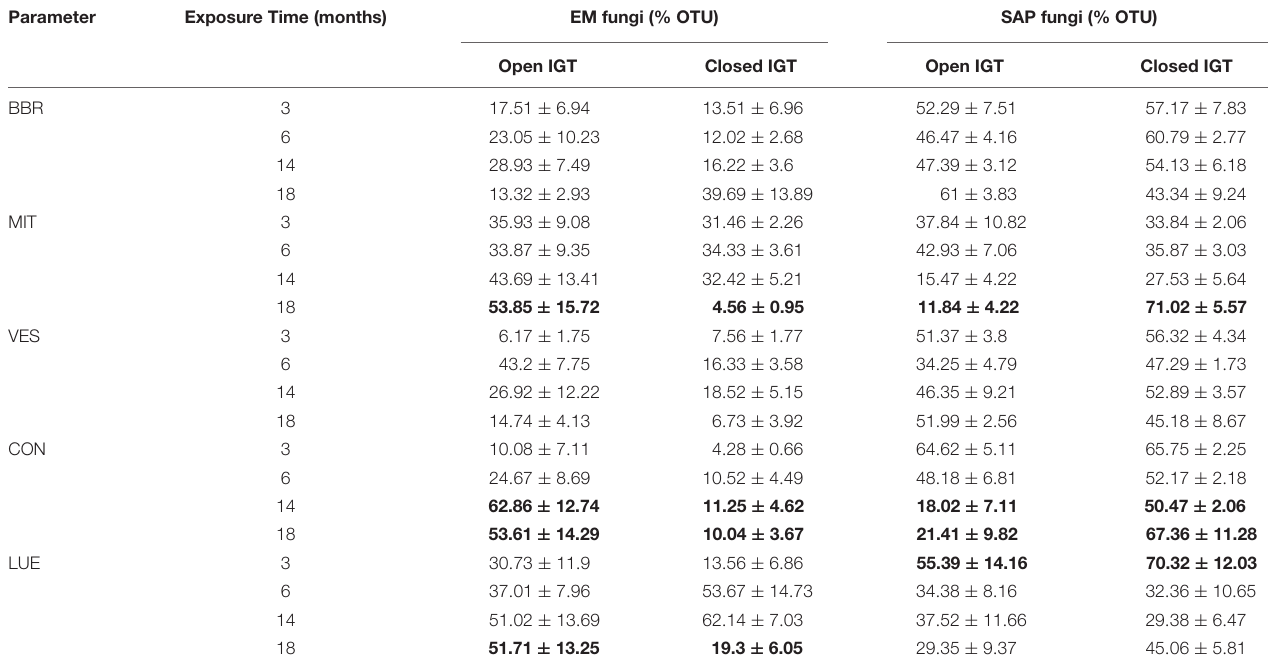
Significant differences of EM and SAP fungi between open and closed IGTs are highlighted in